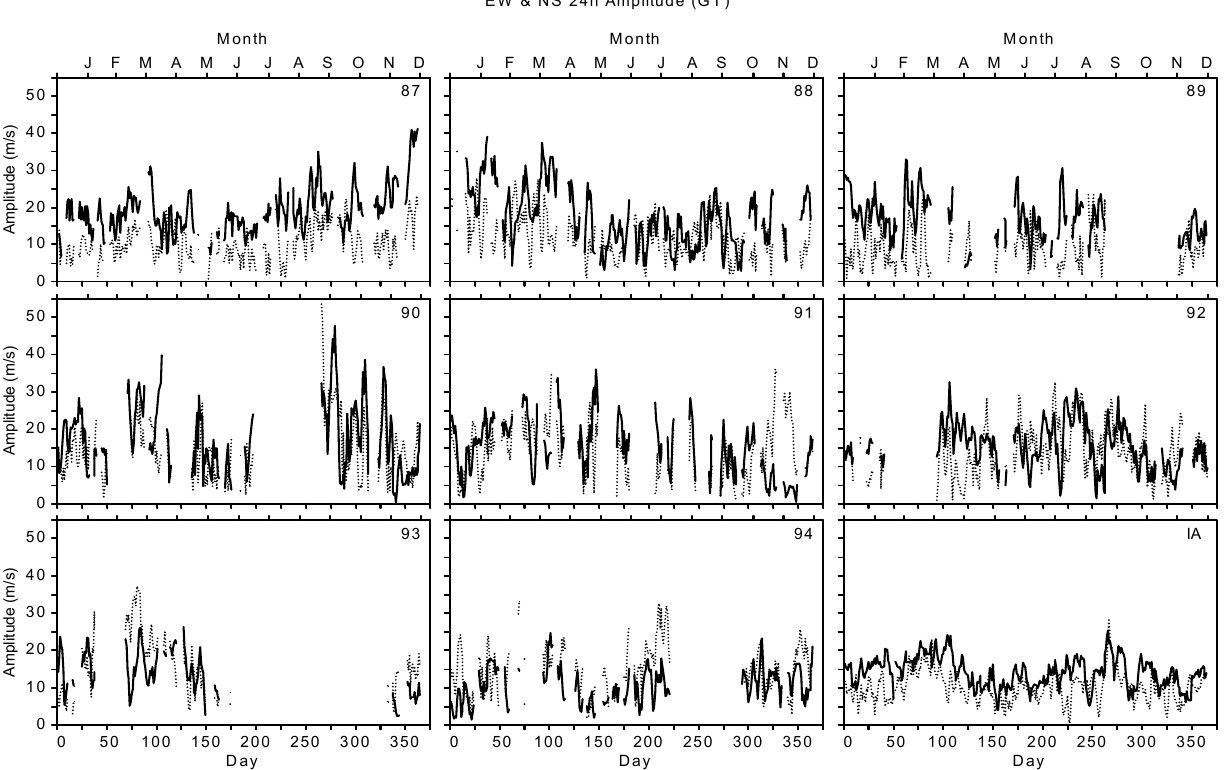
Fig. 1. The zonal (solid line) and the meridional (dotted line) amplitudes of the diurnal tide for the years 1987–1994 and for the corresponding 8-year interannual average (IA) for